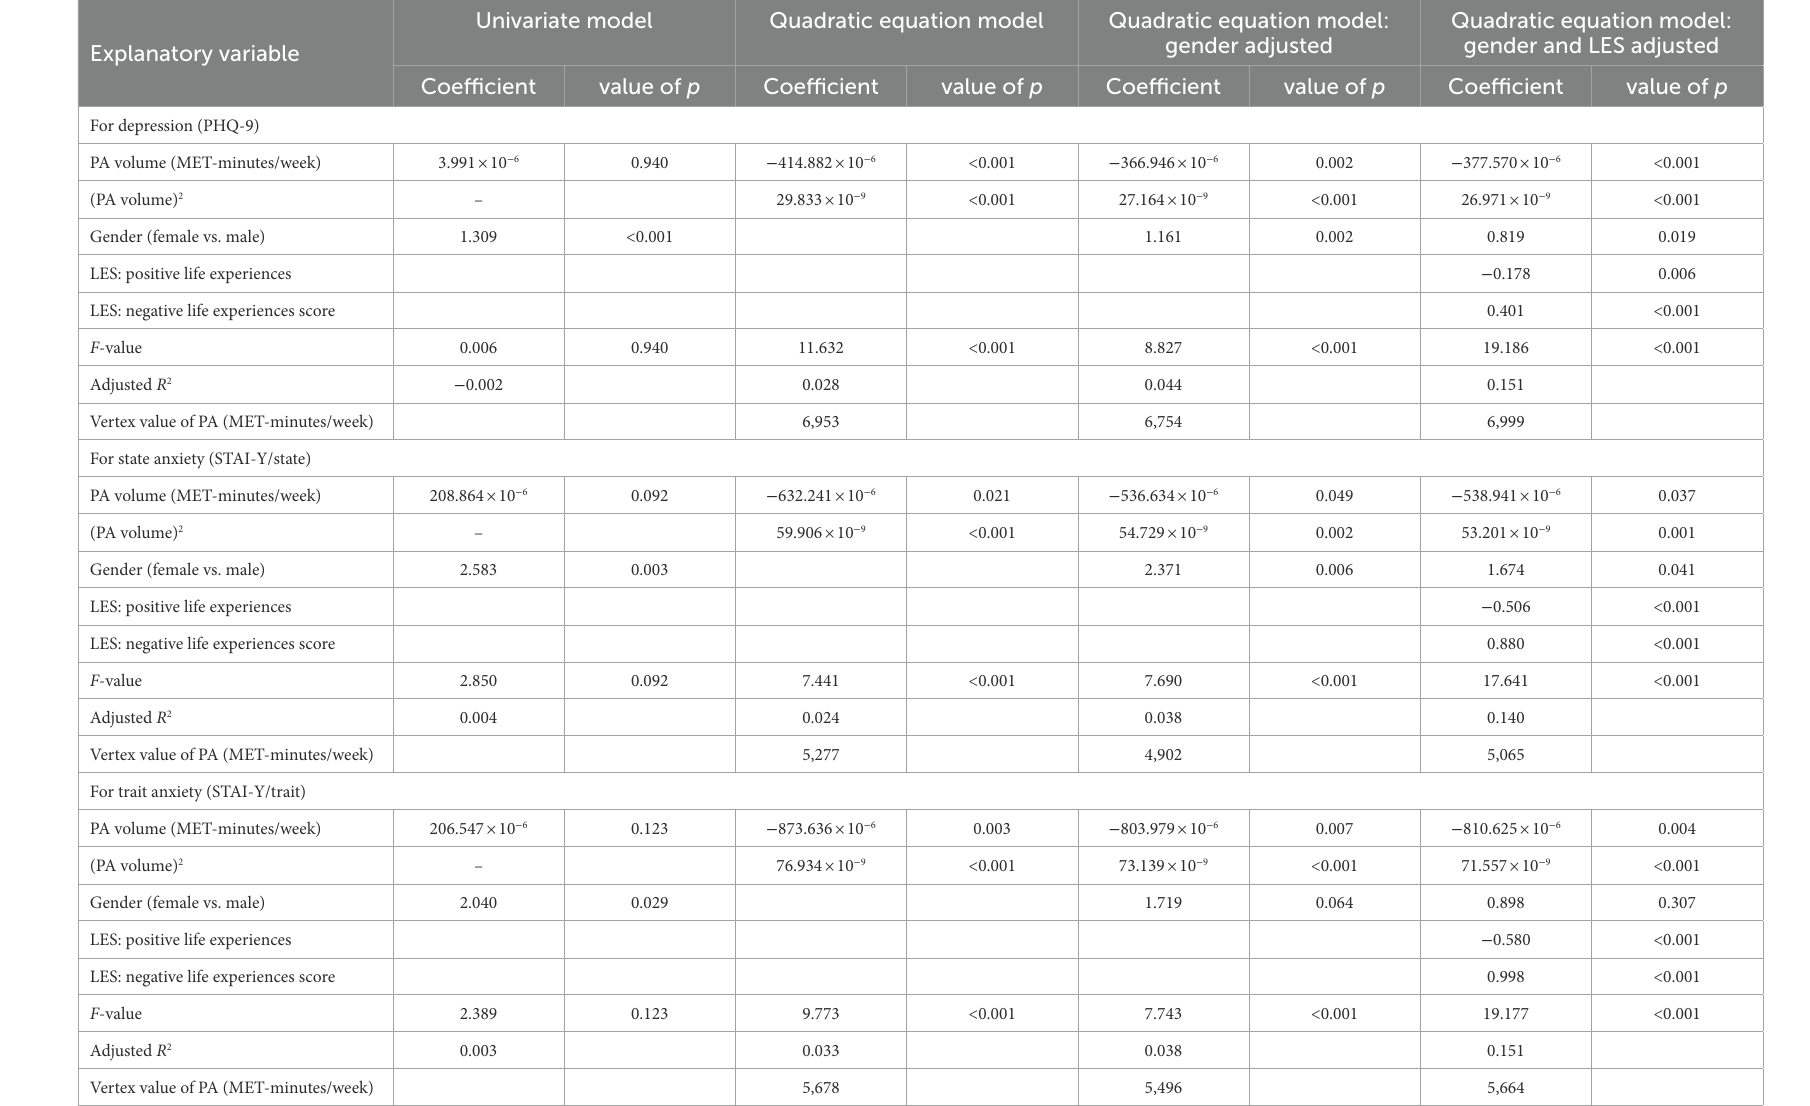
TABLE 2 Regression analyses of the effect of physical activity volume on mental health